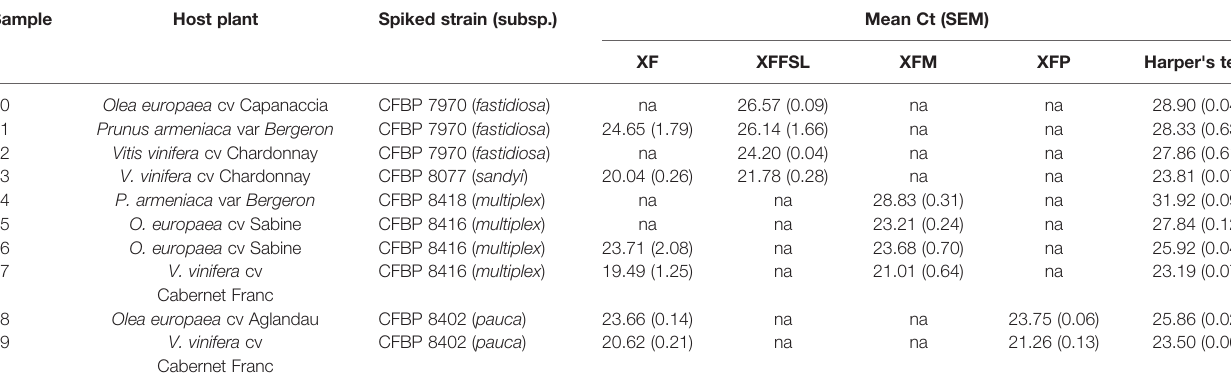
TABLE 7 | Detection of X. fastidiosa in inoculated plants using the tetraplex qPCR assay (set n°1) in comparison with the reference test (Harper's test, Harper et al., 2010). Sample Host plant Spiked strain